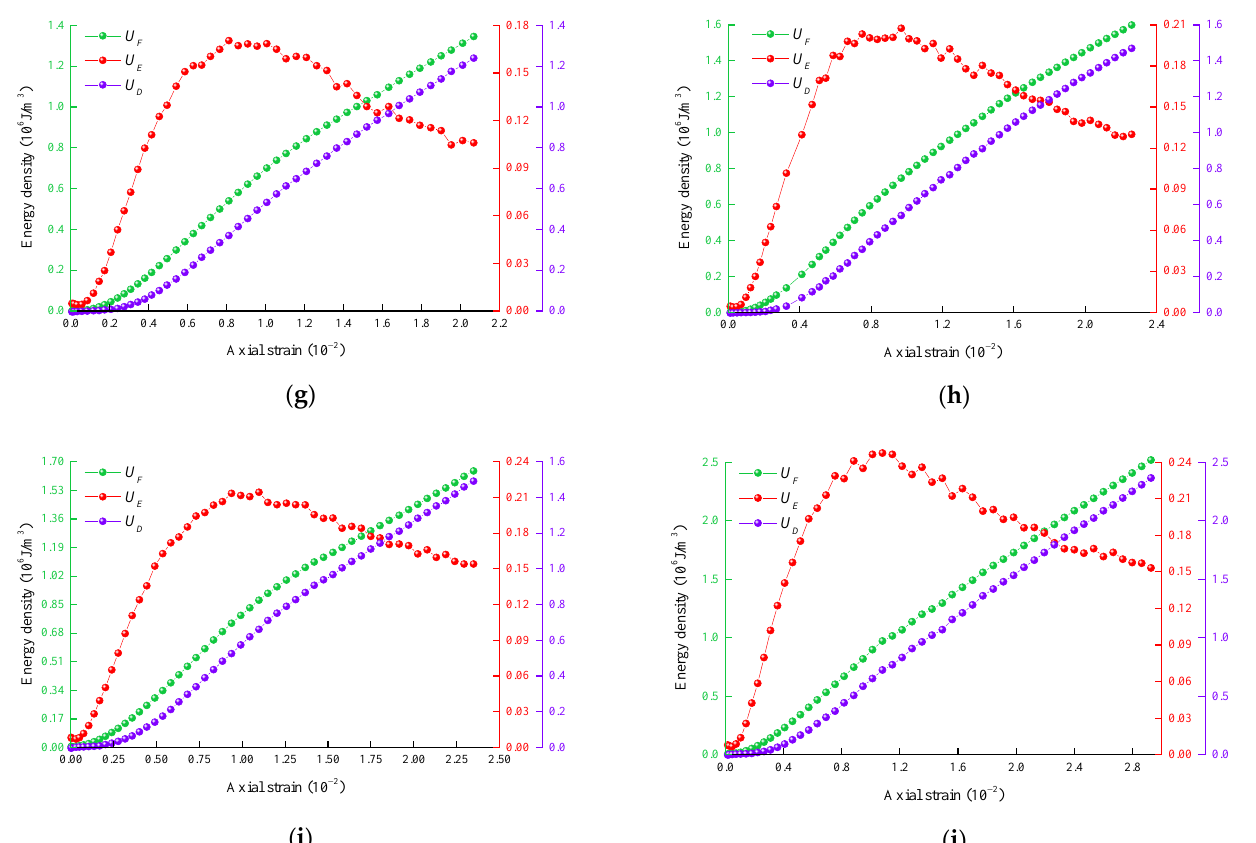
Figure 4. Relationships between energy density and axial strain of high-strength concrete (C60 and C70) at different confining pressures. ( a ) C60, σ 3 = 0MPa; ( b ) C70, σ 3 = 0MPa; ( c ) C60, σ 3 = 5MPa; ( d ) C70, σ 3 = 5MPa; ( e ) C60, σ 3 = 10MPa; ( f ) C70, σ 3 = 10MPa; ( g ) C60, σ 3 = 15MPa; ( h ) C70, σ 3 = 15MPa; ( i ) C60, σ 3 = 20MPa; ( j ) C70, σ 3 =